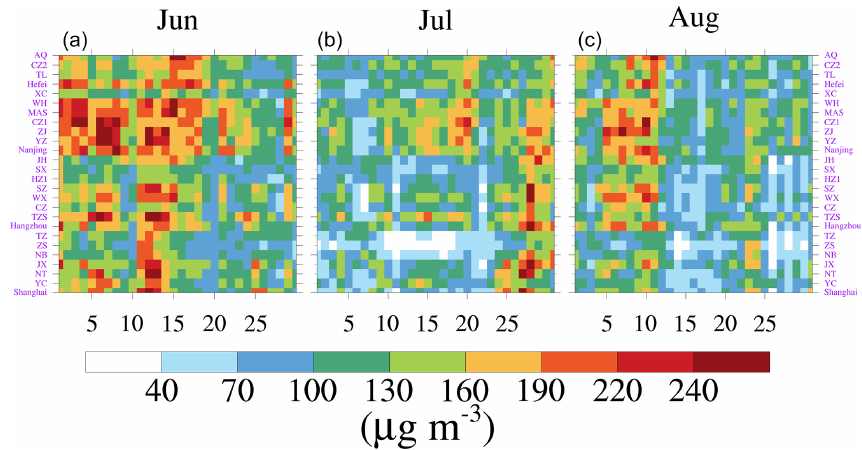
Figure 2. The MDA8 O 3 in 26 cities of the YRD in June (a) , July (b) and August (c) 2018. The national ambient air quality standard for MDA8 O 3 is 160 µgm − 3 in China. These cities are sorted by longitude.